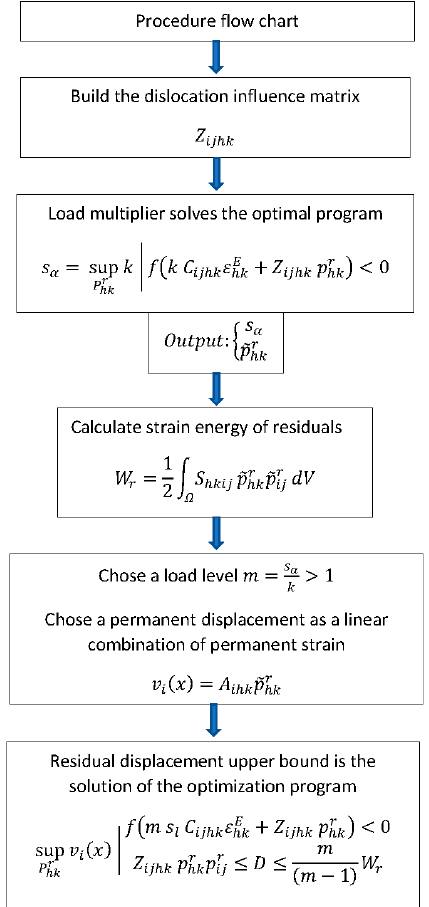
Figure 4. Flow chart of the procedure . Table 1. Material parameters .